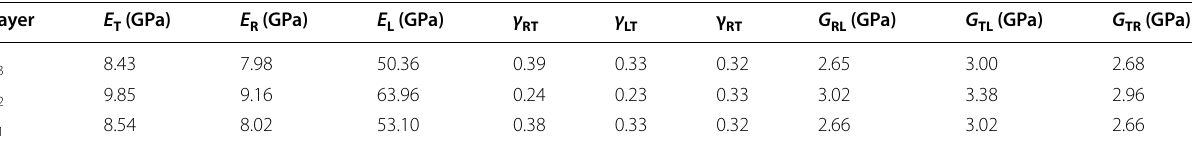
E i is the elasticity modulus in the i direction of cell wall layers; γ ij is the Poisson’s ratio of cell wall layers; G ij is the shearing modulus in the ij in-plane of cell wall layers